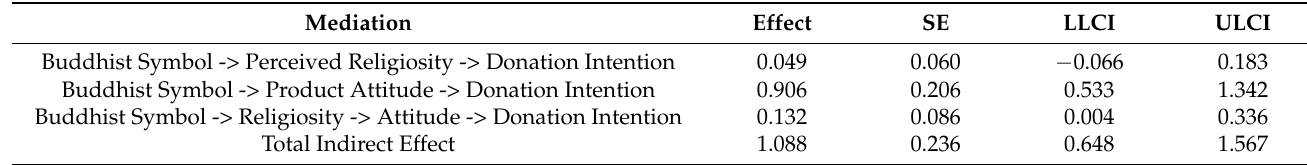
Table 1. The unique and sequential mediation